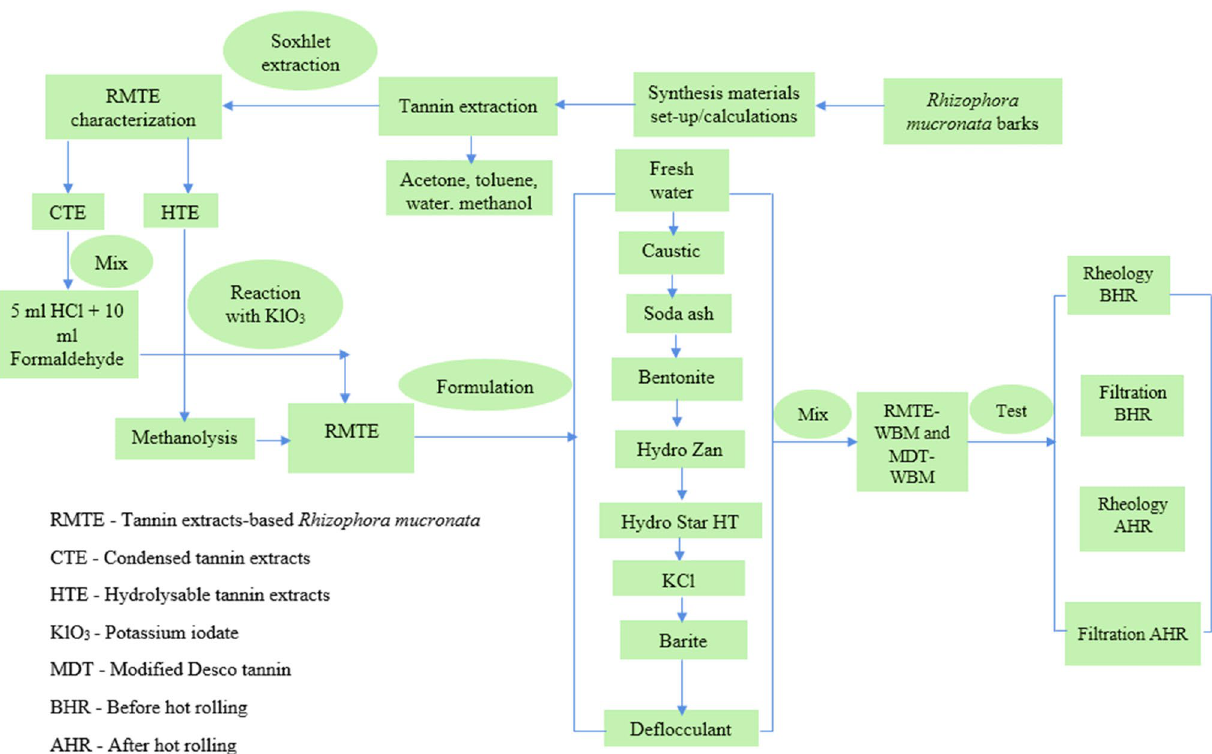
Fig. 2 Flow process used to utilize the production and properties performance of RMTE and MDT-based drilling muds Fig. 3 a Extraction of tannins from RMB wastes placed in the thimble; b draining of the extracted